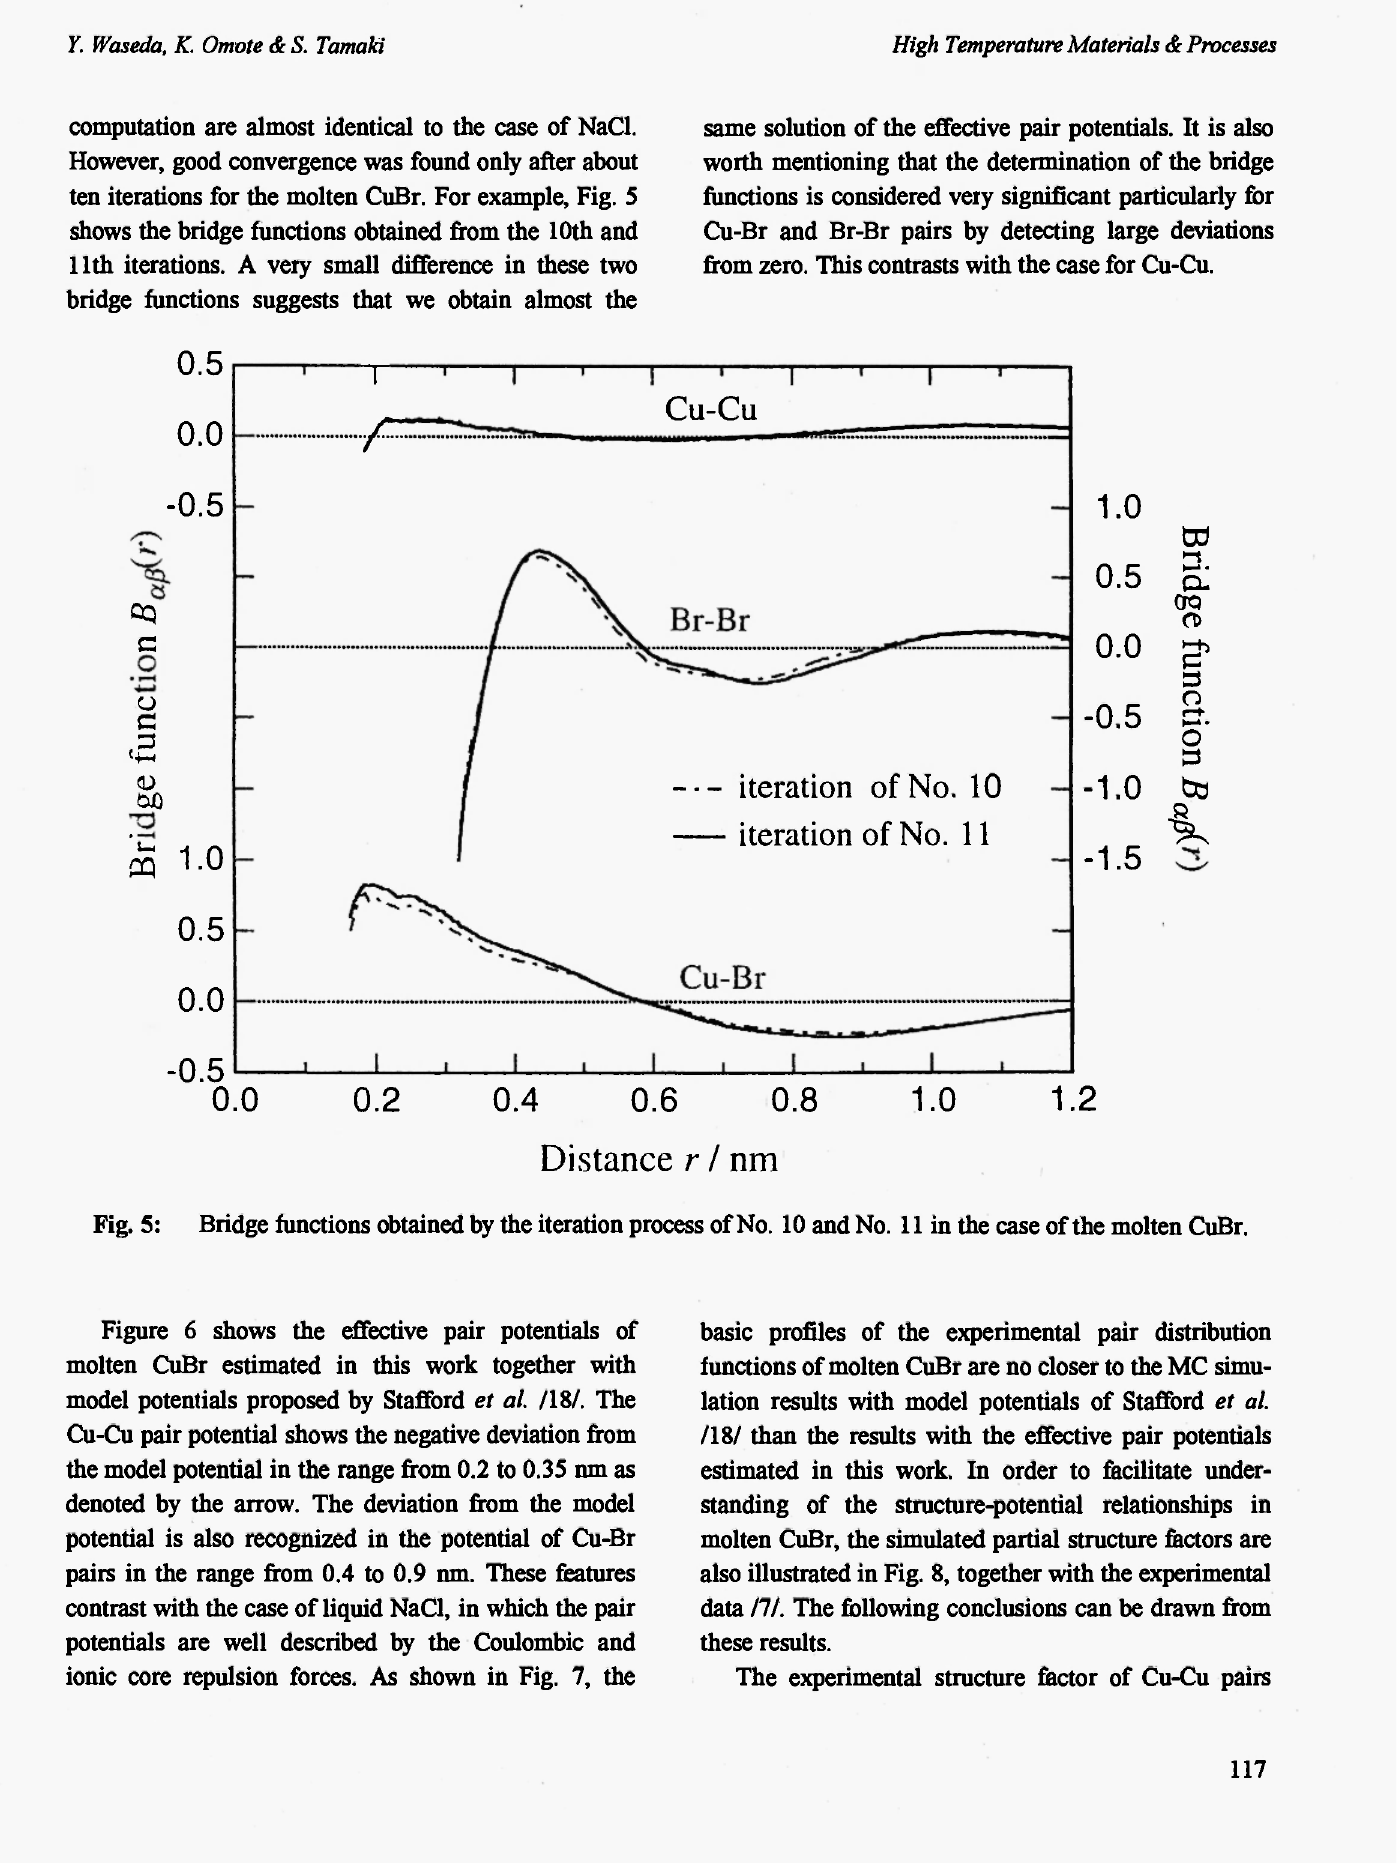
Figure 6 shows the effective pair potentials of molten CuBr estimated in this work together with model potentials proposed by Stafford et al. /18/. The Cu-Cu pair potential shows the negative deviation from the model potential in the range from 0.2 to 0.35 nm as denoted by the arrow. The deviation from the model potential is also recognized in the potential of Cu-Br pairs in the range from 0.4 to 0.9 nm. These features contrast with the case of liquid NaCl, in which the pair potentials are well described by the Coulombic and ionic core repulsion forces. As shown in Fig. 7, the